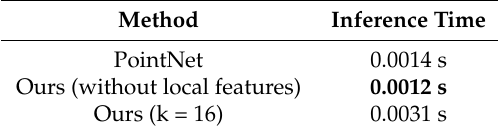
Figure 13. Training curves. ( a ) mean accuracy ( b ) dropper accuracy ( c ) loss. Table 2. Comparison of the average inference time per sample.